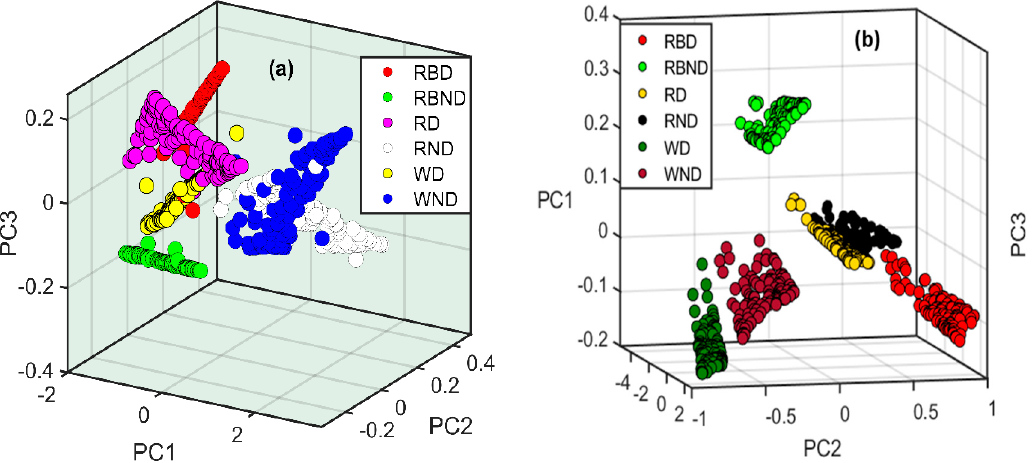
Figure 7. Principal component analysis of Arabidopsis thaliana powder samples for ( a ) FT − IR and ( b ) FT-NIR spectroscopy under different stress conditions. Here, the abbreviations RBD, RBND, RD, RND, WD, and WND stand for red+ blue drought, red+ blue non-drought, red drought, red-blue non-drought, white drought, and white non-drought.